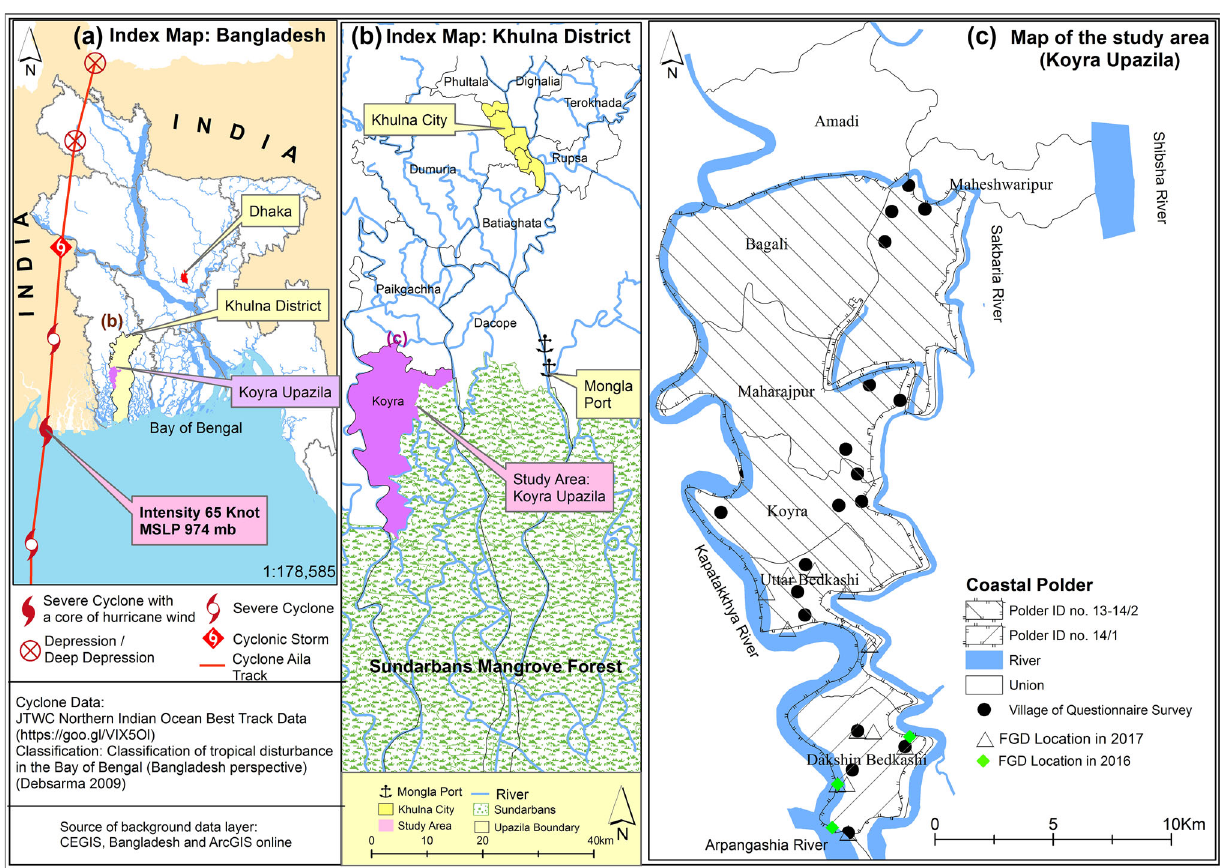
Fig. 1 Map of the study area, Koyra Upazila (subdistrict), Khulna District,